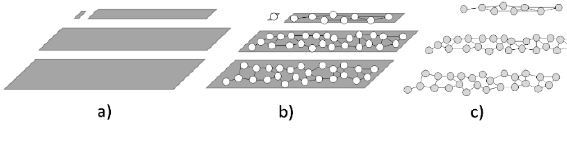
Figure 6. Connected components for horizontal regions: a) points with horizontal tilt, b) adjacency relation between points, c) points grouped.